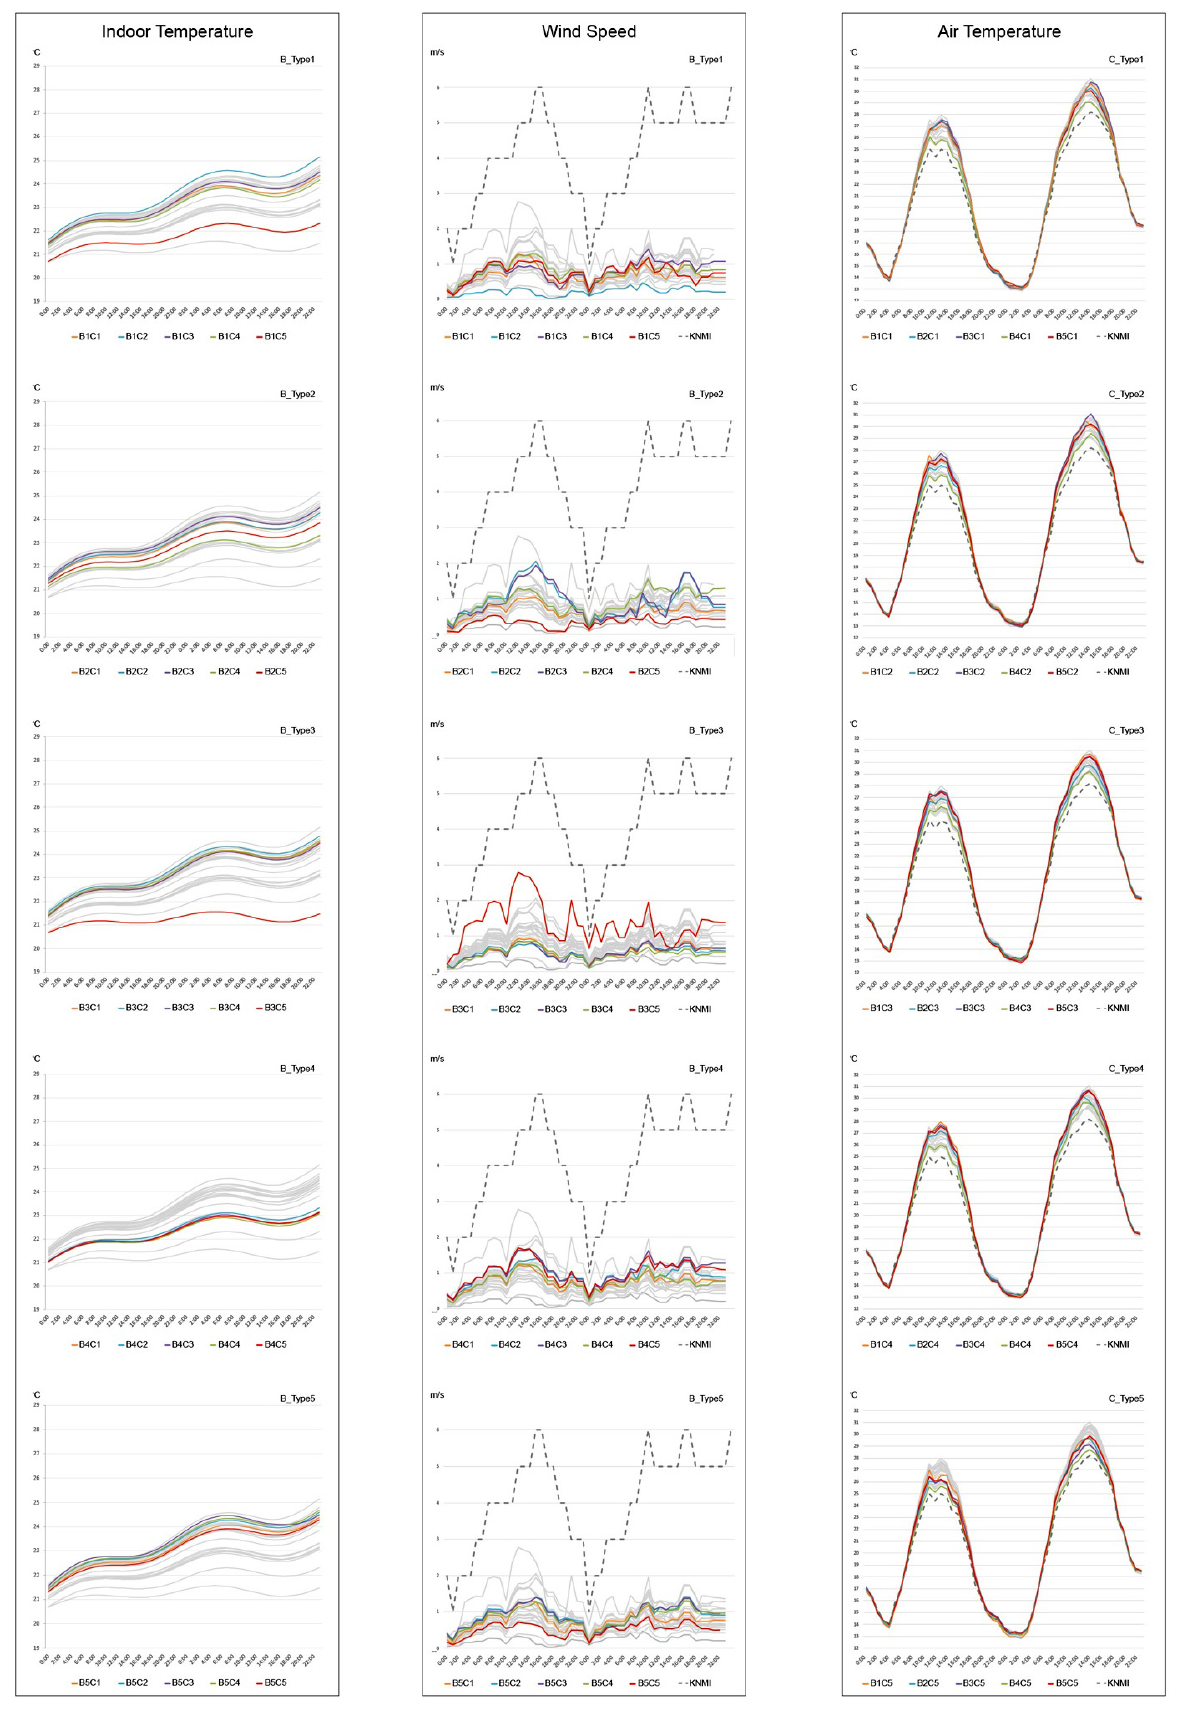
Figure 7. Indoor temperature values (left) and wind speed values (centre) for each building type; air temperature values for each context type